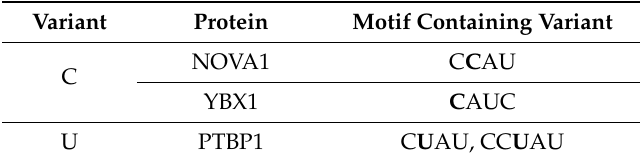
Table 4. Motif sequences of possible protein-binding sites in C-variant and U-variant found in ATtRACT database. SNPs are marked as